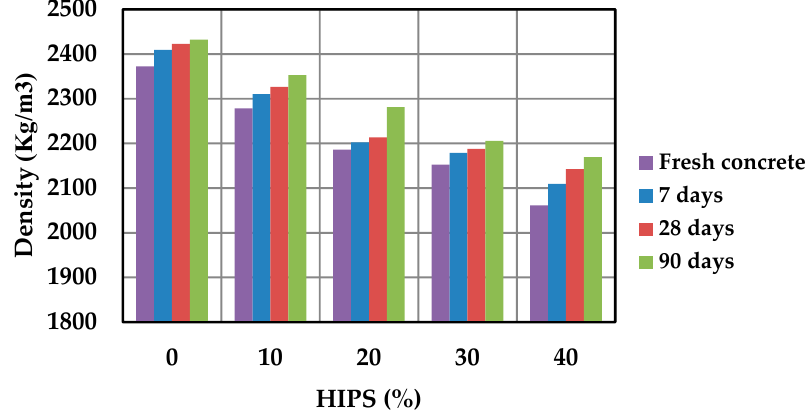
Figure 8. Unit weight variations with respect to HIPS (%) replacement for sand. 266